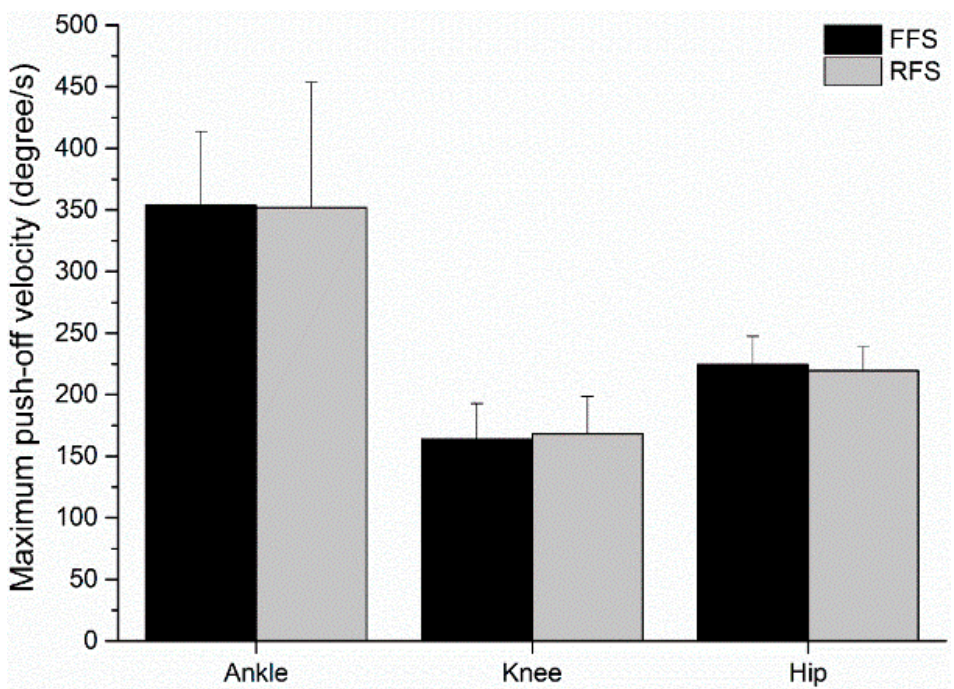
Figure 4. Maximum velocity of push-off of FFS and RFS pattern during stance phase. Note: FFS = forefoot strike pattern; RFS = rearfoot strike pattern.